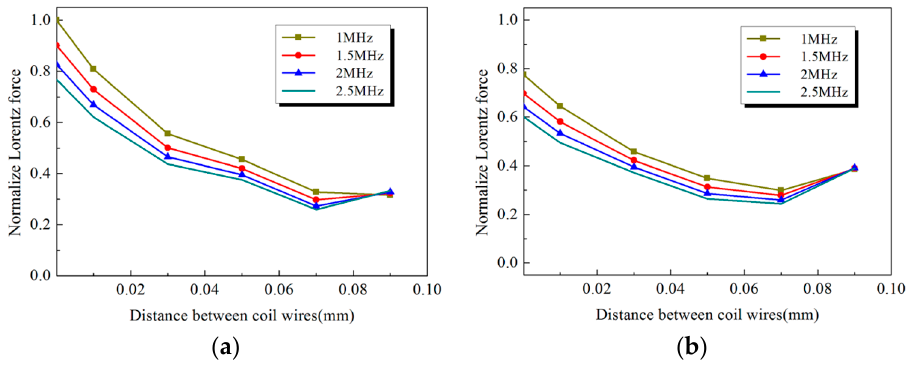
Figure 7. Normalized Lorentz force in skin depth with different distances between coil wires and excitation frequencies. ( a ) Square cross-section; ( b ) Round cross-section.